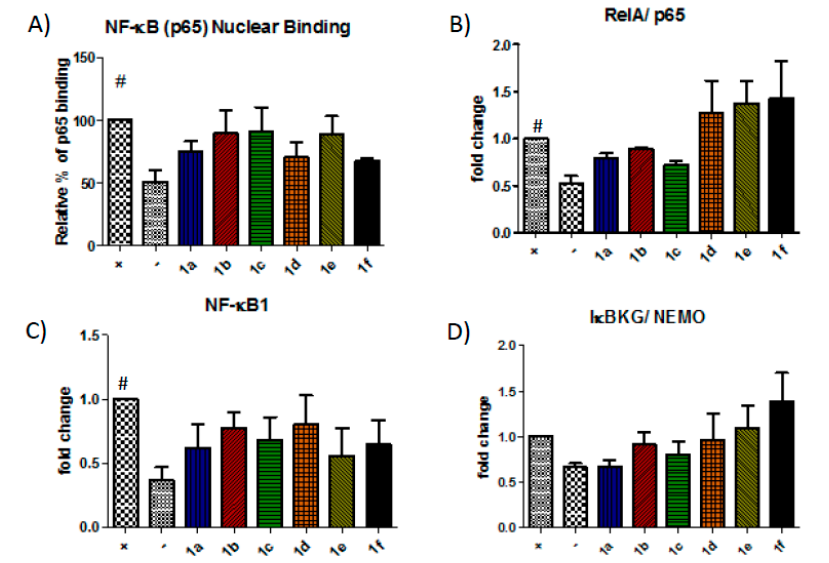
Figure 5. The barbiturate-nitrate hybrids show little effect on the NF- κ B pathway. The nuclear translocation and binding of the NF- κ B subunit p65 was measured using ELISA ( A ) and the gene expression of RelA/p65, NF- κ B1/p105 and a component of the IKK complex, I κ BG/NEMO were measured using qPCR ( B , C , D ). # p < 0.05 vs unstimulated Caco-2 cells (negative control).